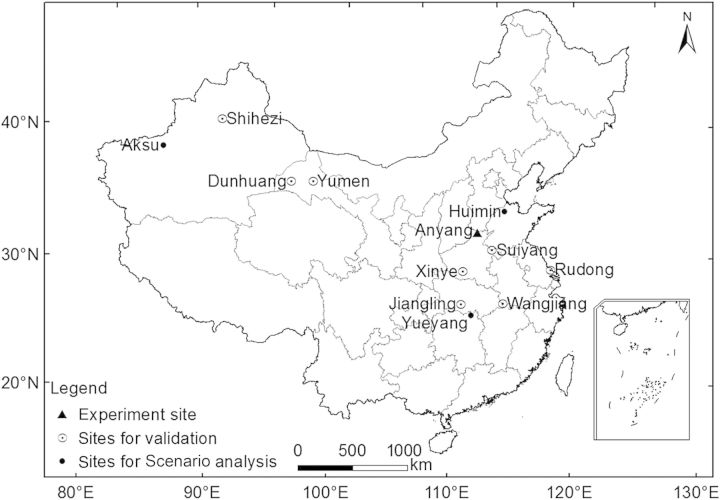
Locations of study sites for calibration, validation and scenario analyses.